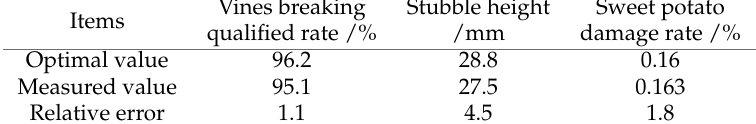
Table 5. Comparison of optimized value and test average